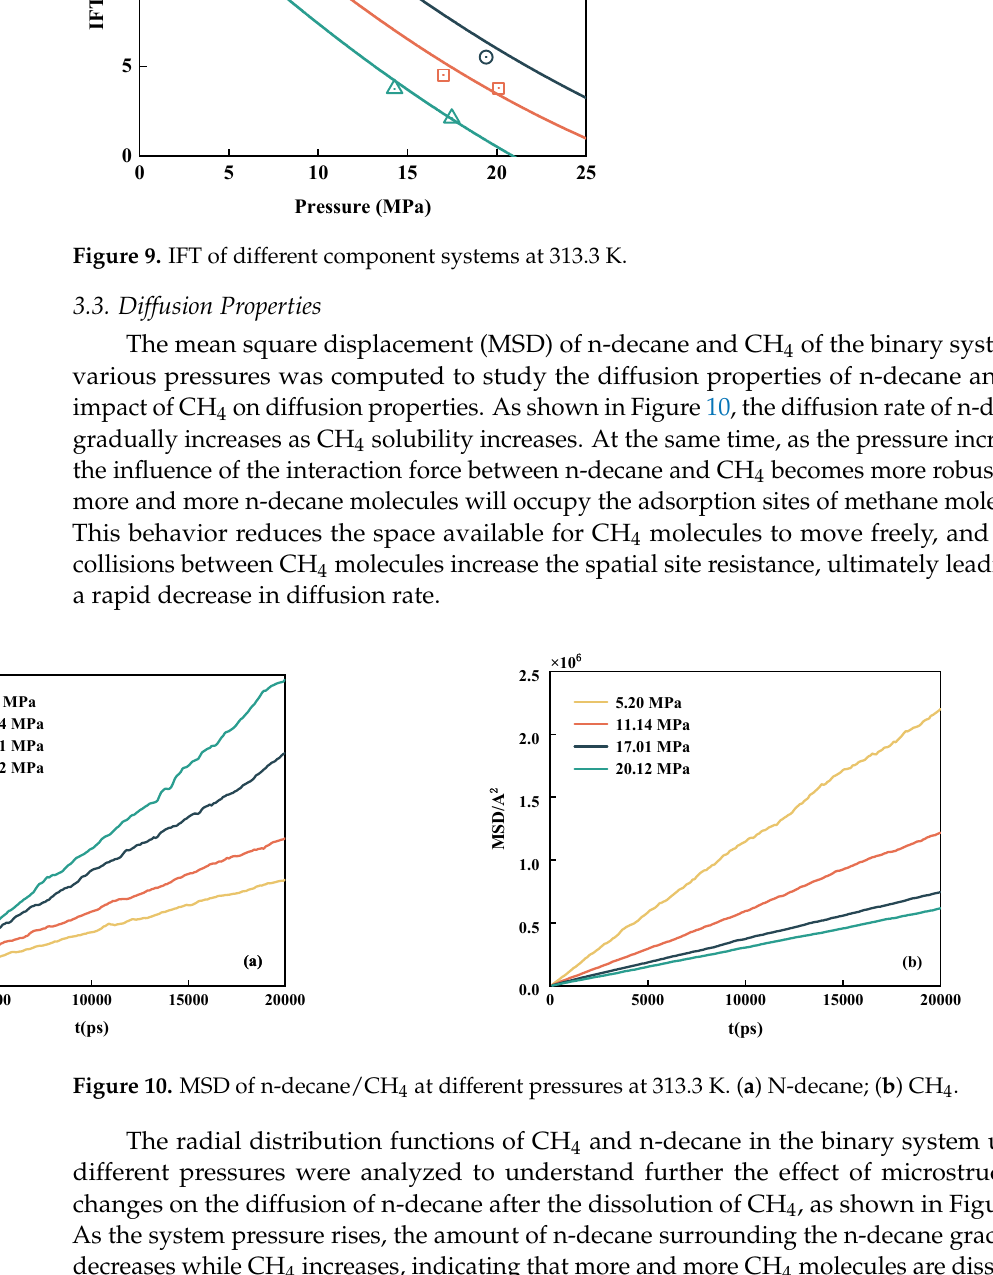
Figure 11. Radial distribution function of n-decane/CH 4 (313.3K). ( a ) N-decane-n-decane; ( b ) n-dec- ane-CH 4 . Figure 12 shows the radial distribution function between n-decane-CH 4 and n-dec- ane-CO 2 at 313.3 K and 11.14 MPa. N-decane interacts with CO 2 more potently than CH 4 , resulting in a large number of CO 2 molecules gathering around n-decane, limiting CH 4 flow and decreasing the diffusion capacity of CH 4 molecules. This result indicates that the interaction of carbon dioxide with n-decane is greater than that of CH 4 .